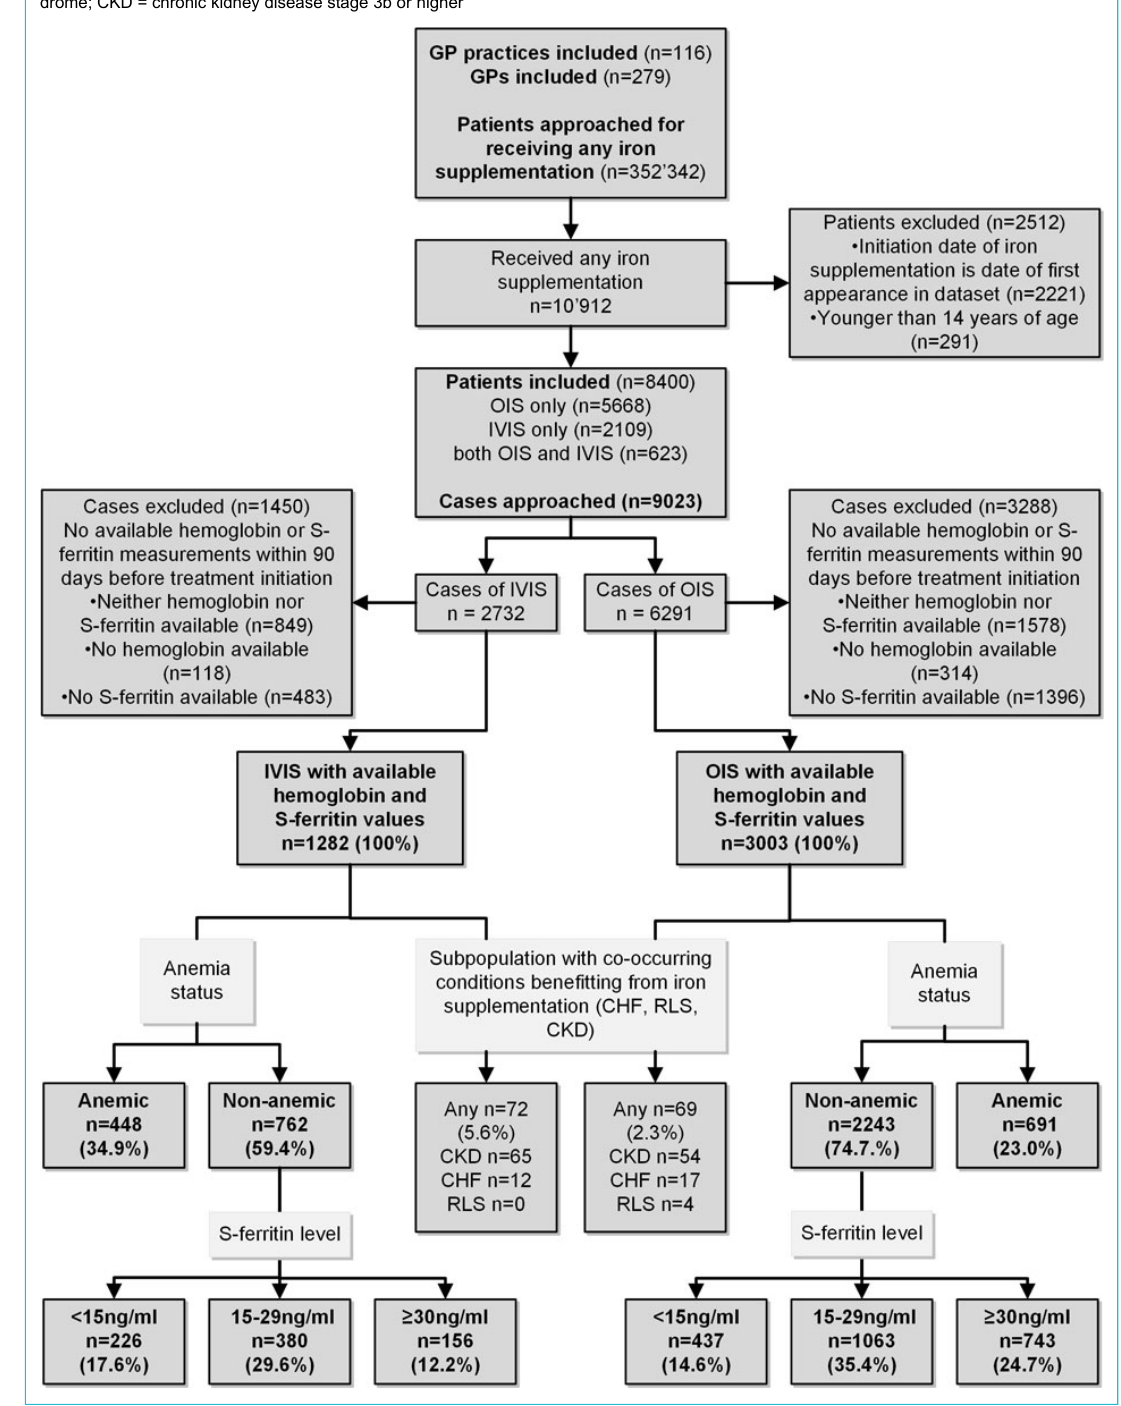
Figure 1: Study design and inclusion/exclusion criteria including numbers of patients and cases. GP = general practitioner; OIS = oral iron supplementation; IVIS = intravenous iron supplementation; S-ferritin = serum ferritin; CHF = chronic heart failure; RLS = restless legs syn- drome; CKD = chronic kidney disease stage 3b or